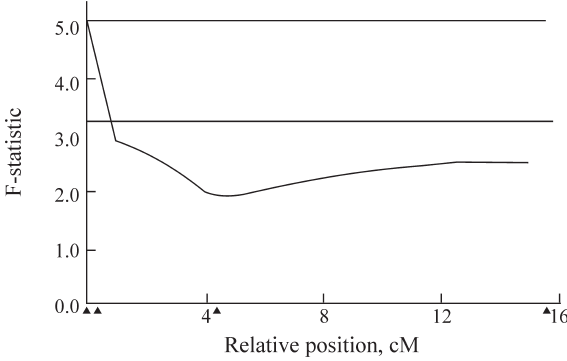
Figure 3 - F-statistic profile for breeding value for yearling weight in the analyzedintervalof15.5cM.Theupperhorizontallinerepresentsasignif- icance level of 0.01 and the lower represents a significance level of 0.05 (F-statistic = 5.17 at 72.9 cM). Arrowheads under the X-axis indicate the relative position of the markers on the chromosome, beginning at the centromeric extremity. From left to right: ILSTS066 (72.9 cM), IGF-1 (73 cM), TEXAN15 (77.2cM) and BMS1248